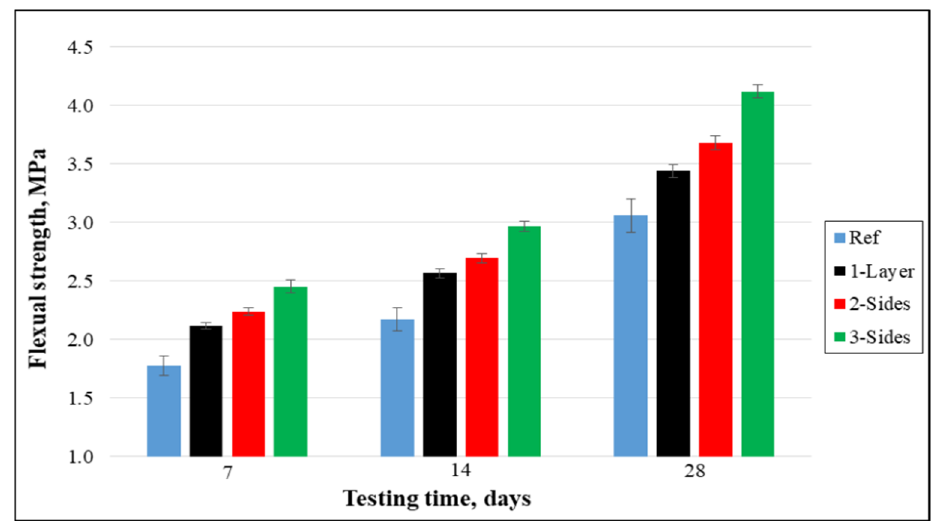
Figure 7. Flexural strength of concrete samples.